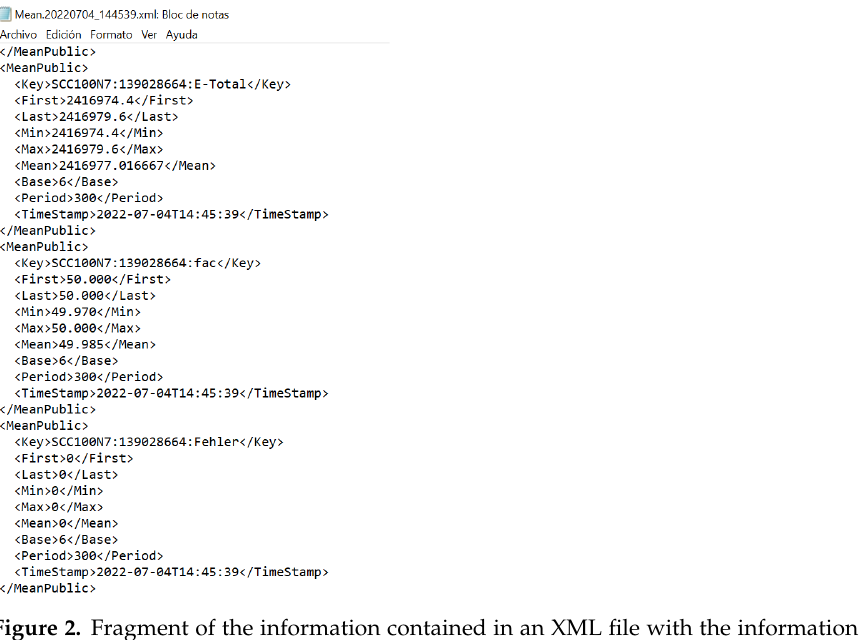
Figure 4. Part of the contents of a CSV file opened in Microsoft Excel from the monitoring of a PV plant. In both formats, the migration scripts were coded in such a way that each piece of data must be assigned to the parameter to which it corresponds, the inverter or sensor that records it, as well as the day and time to which the data corresponds. As already indicated, how this process was carried out will depend on the internal structure of the file (Figures 2 and 4). In general, to process the data, a series of steps will be required in the migration script in order to have access to read the directories where the data are located, decompress the files if necessary, read the files where the data are located (for example, in the case of XML files, only those beginning with Mean), extracting information from the headers or first lines of the file, which are usually standardised, to know which parameters are being measured and to which inverters or sensors they correspond, in the case of CSV files, or extracting this information through the structure of the XML format files. It is also essen- tial, for each piece of data, to extract the date and time to which it corresponds, which, as has been seen, can be both in the name of the file and in the information stored in its internal structure, depending on the file format. It should be noted that one of the fields that are stored in the common database referring to the characteristics of each PV instal- lation is the coordinates corresponding to the geographical location of the plant. This al- lows the date and time of the data to be associated with the local time of that geographical location; and when the measured data are stored in the individual databases of each in- stallation, they are obviously stored with the local time. Once all this information is lo- cated, all the parameters of each inverter and sensor are distributed and entered in the corresponding databases, and specifically, in the fields of the tables assigned to them. Since each PV plant to be studied has its own particularities, it is important to adapt the migration script to each one so that it corresponds to the file format they have and adapts to the characteristics of each so that there are no errors in the data migration. For example, whether or not they have weather data, and if not, from where to read these values. This avoids mixing configurations and minimises errors.